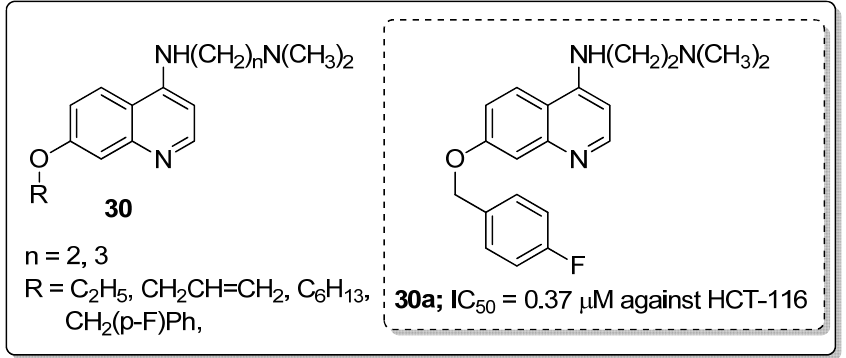
Figure 35. Antiproliferative activity of the most active quinoline conjugate 30a .